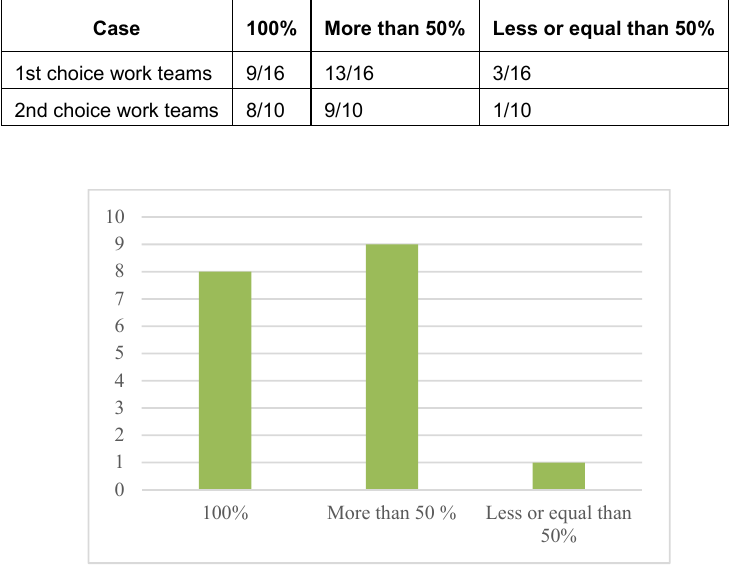
Figure 3. Number of second choice work teams with more than 50% correspondence using the fusion of KSA models and the Apriori algorithm